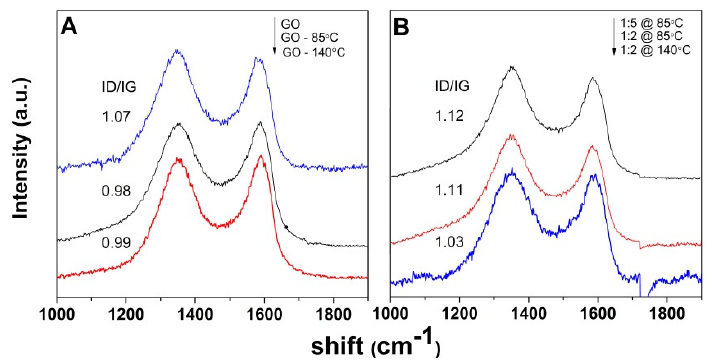
Figure 6. Raman spectra of GO and GO aerogels obtained at 85 and 140 °C ( A ) and EDA-functionalized GO aerogels from a 2 mg·mL − 1 GO dispersion and varying GO/EDA ratio ( B ).